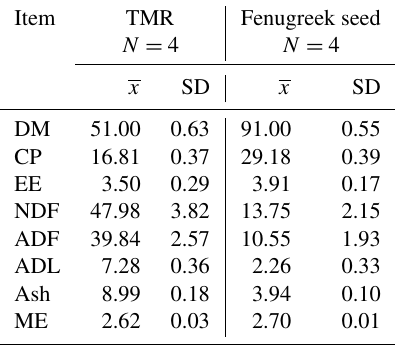
Table 1. The chemical composition of the total mixed ration (TMR) and fenugreek